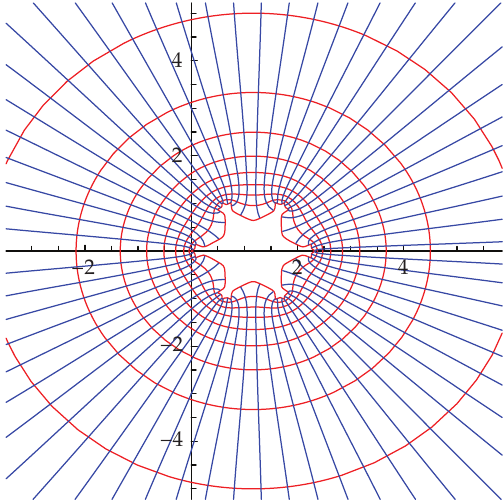
Figure 15: Exterior of the Koch snowflake, Step